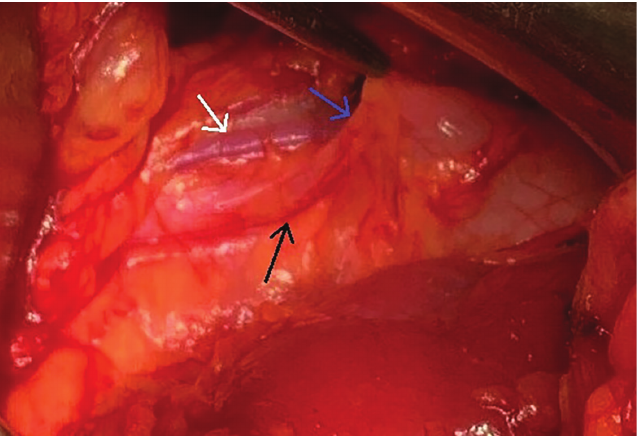
Figure 1. UPJ area in open dismembered ureteropyeloplasty. White arrow – testicular vein; blue arrow – ureter; black arrow – ureteral artery.